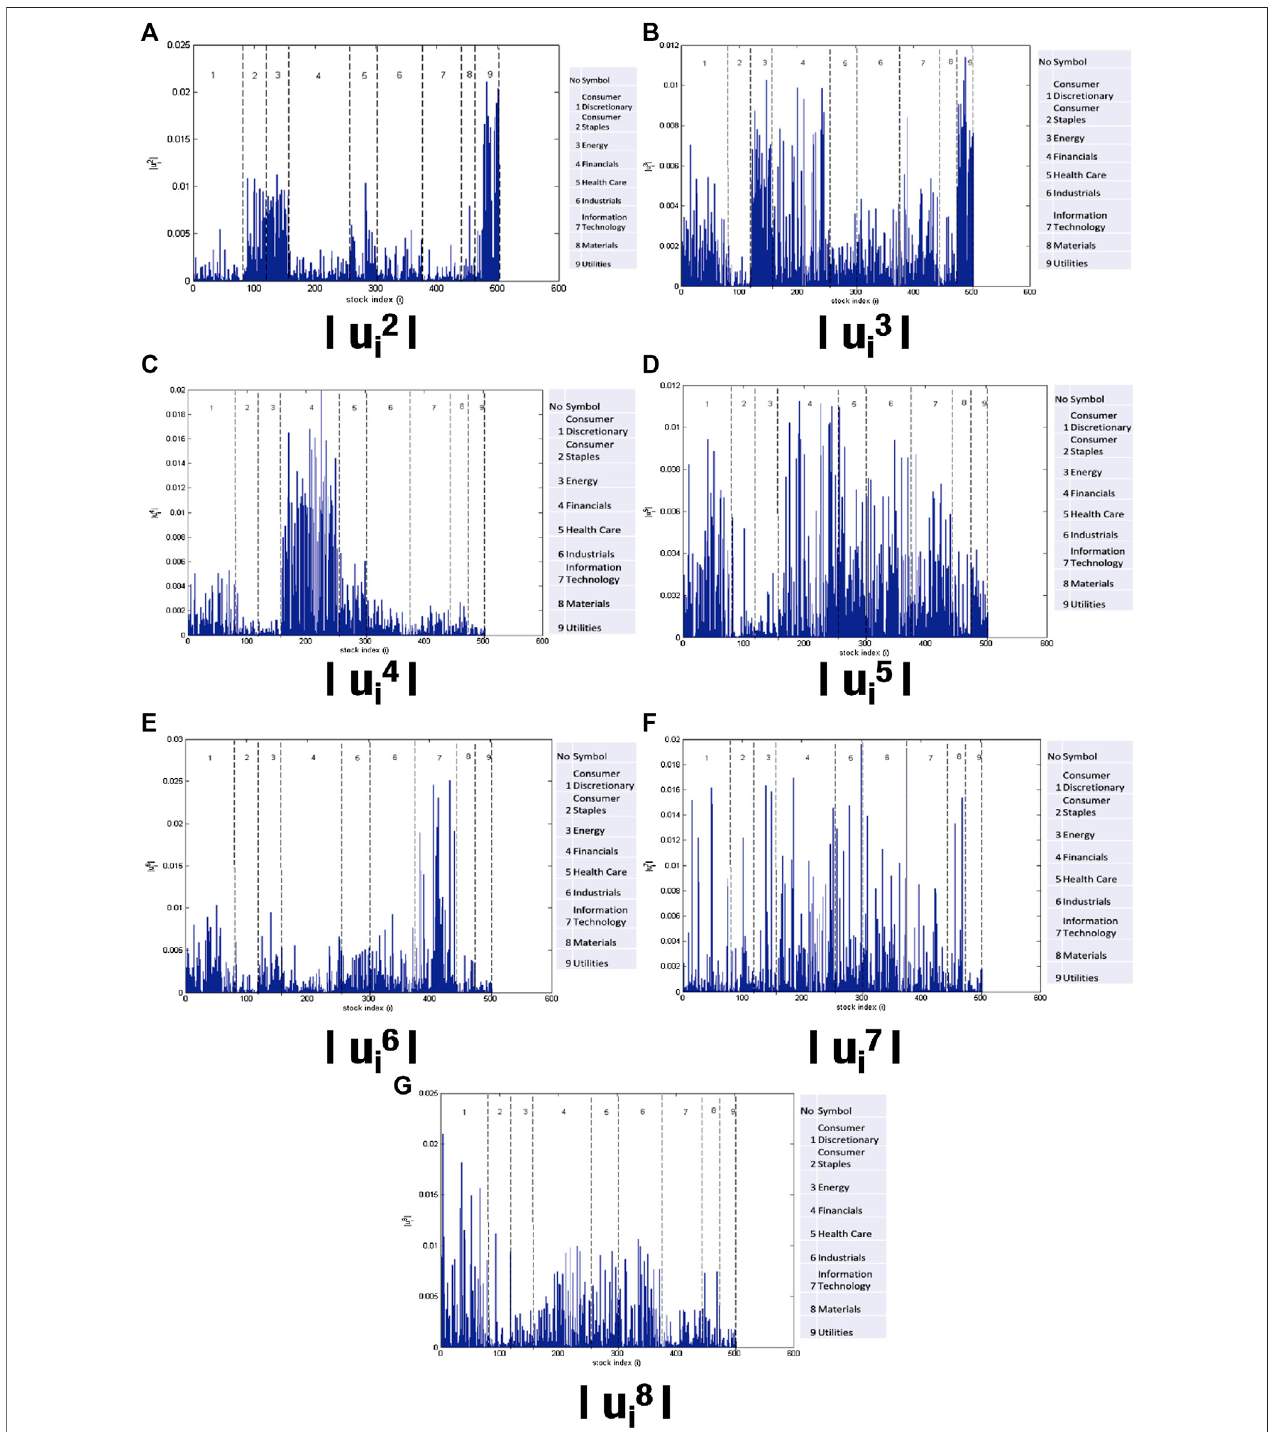
FIGURE 7 | There are many information for each Eigen vectors. Some sectors overlap in several Eigen vectors. This indicates that we require a method to reveal communitydetection. Thevectorcomponentof u 2 – u 8 fromthematrixof C ,thearrangementofthestockbasedonthesectors,1:consumerdiscretionary;2:consumer staples; 3: energy; 4: fi nancials; 5: health care; 6: industrial; 7: information technology; 8: materials; dan 9:utilities; from the daily stocks of S&P 500 for the period of January 1, 2007 until October 28, 2016.